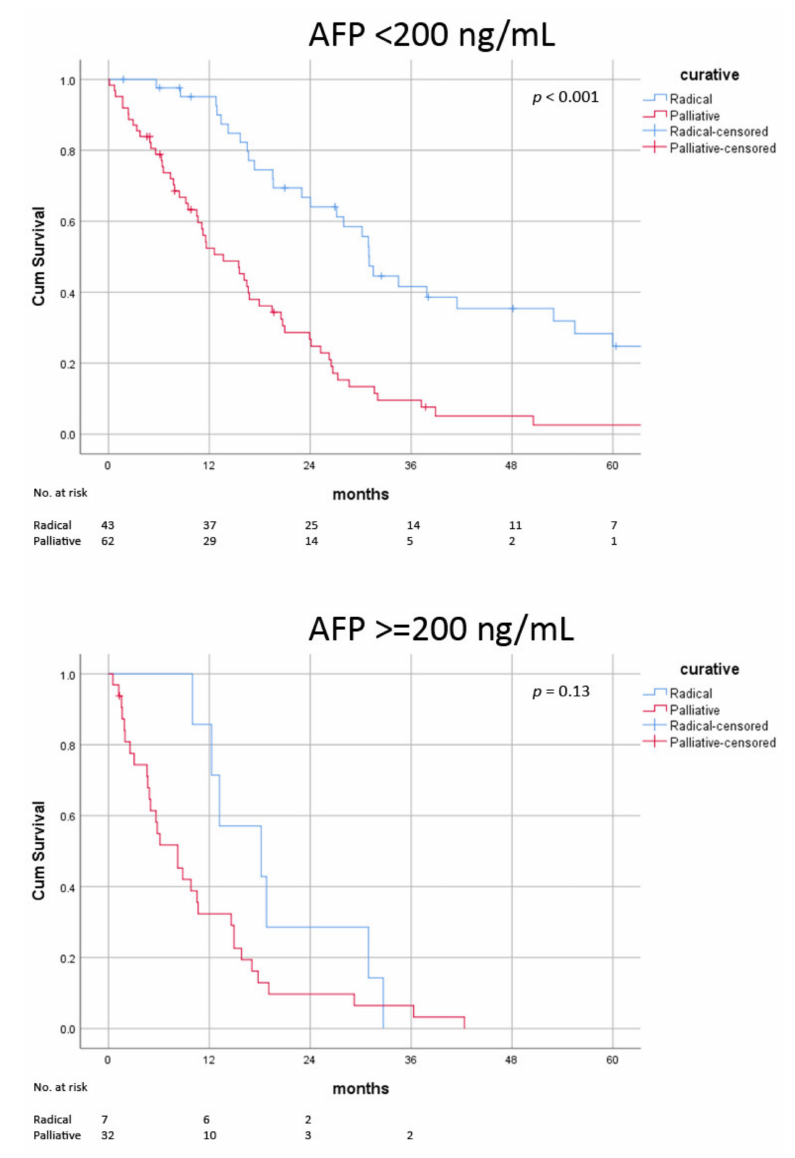
Figure 4. Post-recurrence survival of radical versus palliative treatment in low and high AFP level. Table 6. Survival outcomes of radical versus palliative treatment stratified by biological risk